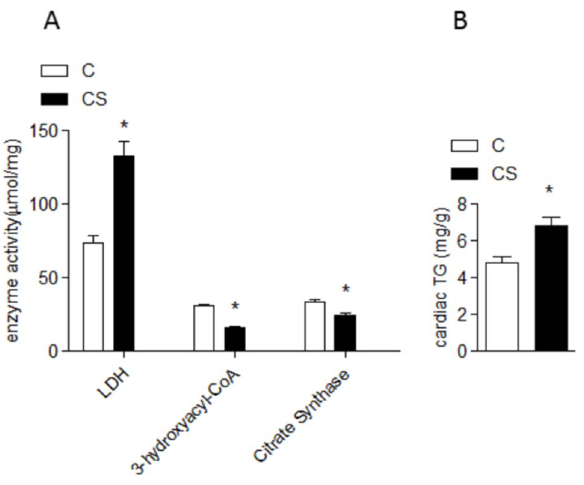
Figure 1. Energy Metabolism. C: control group; CS: cigarette smoke group; LDH: lactate dehydrogenases C vs. CS p , 0.001; 3-hydroxyacyl-CoA: 3-hydroxy acyl coenzyme A dehydrogenases C vs. CS p 5 0.004; citrate synthase C vs. CS p 5 0.008; cardiac TG: cardiac triacylglycerol C vs. CS p 5 0.004.